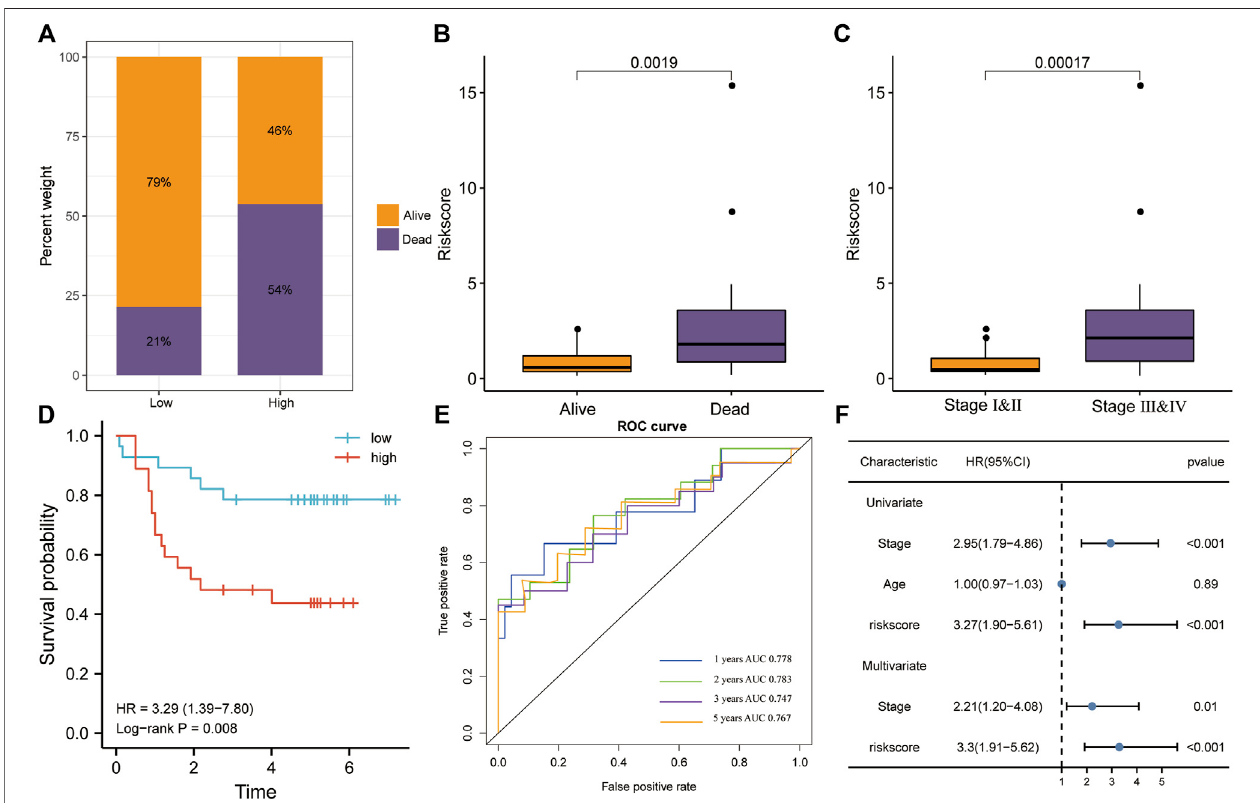
FIGURE 7 | Veri fi cation of the risk model in the GSE52903 dataset. (A) The high-risk group had higher mortality rates. (B) The risk score was signi fi cantly higher in the mortalitygroup duringfollow-up. (C) Patients instages III – IV had signi fi cantlyhigher riskscores. (D) Patientswithhighriskscoreshad apoorerprognosis,according to KM analysis for OS. (E) The ROC analysis revealed that risk scores accurately predicted OS. (F) Univariate and multivariate Cox regression for OS revealed that risk score was the only signi fi cant independent risk factor among included clinicopathological